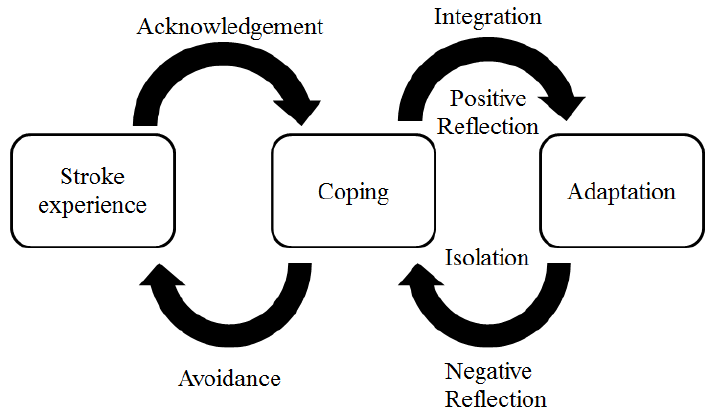
Figure 1. Conceptual model.